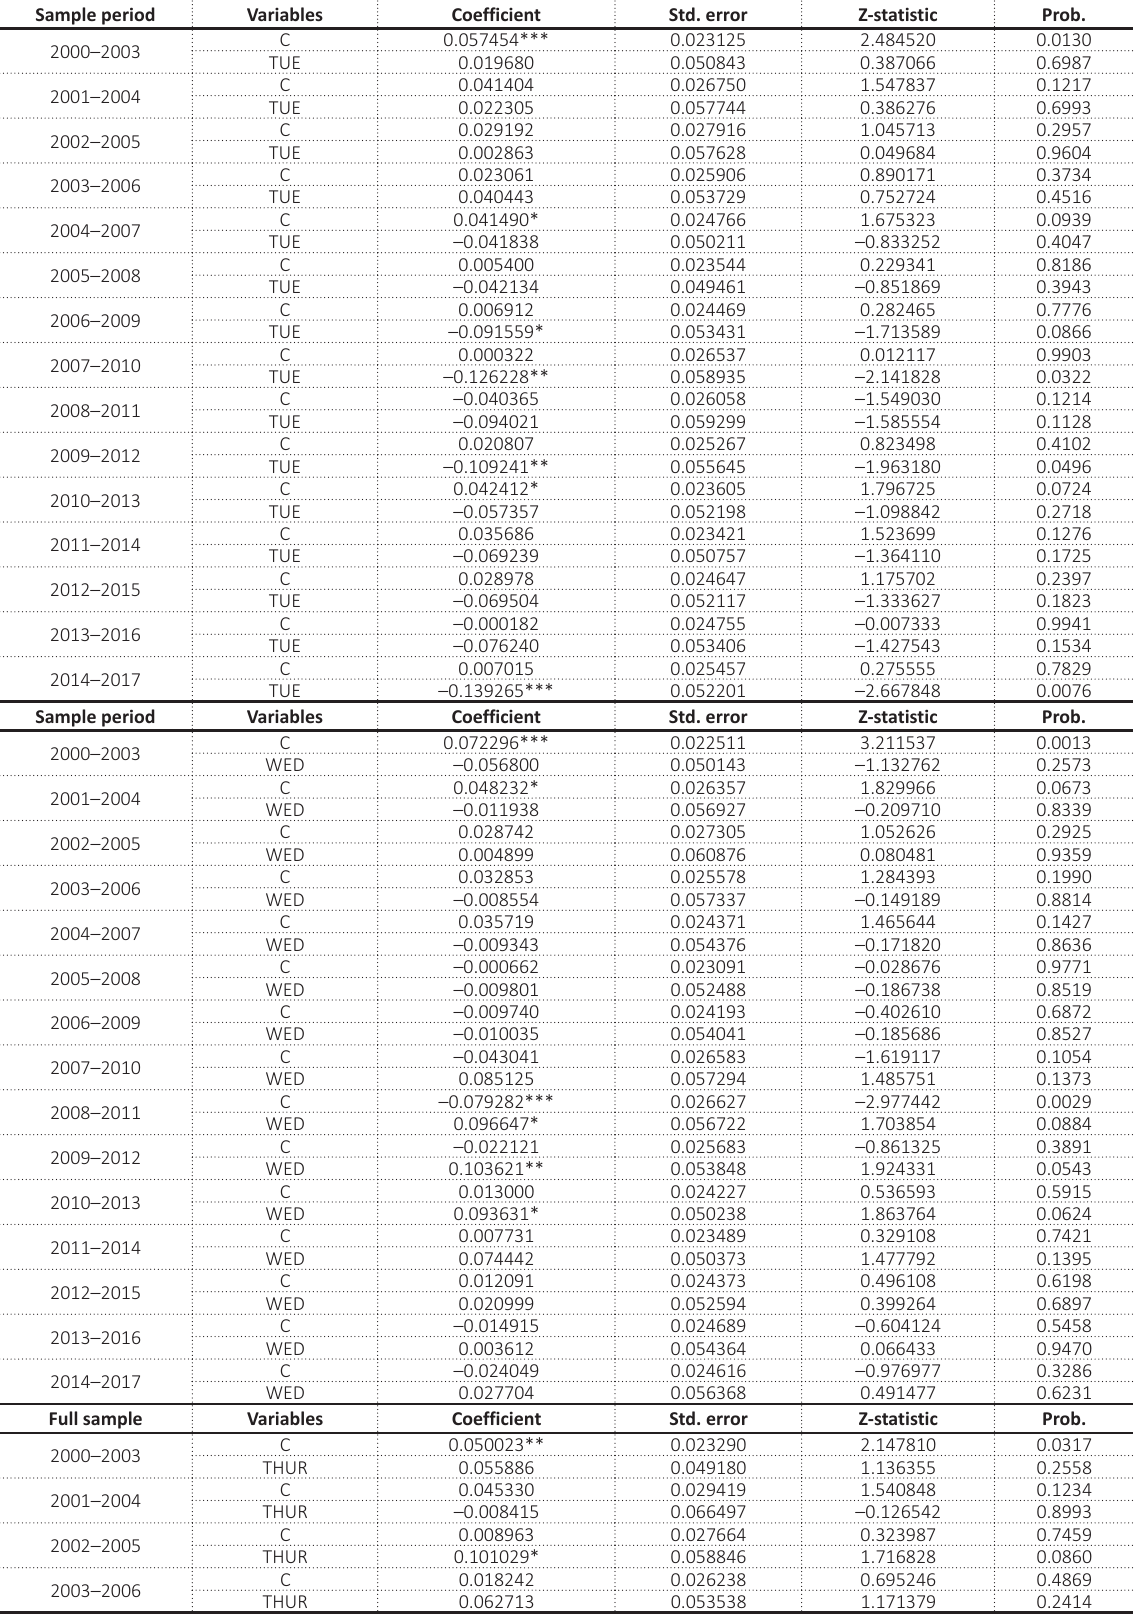
Table 2 (cont.). Results of time-varying day-of-the-week